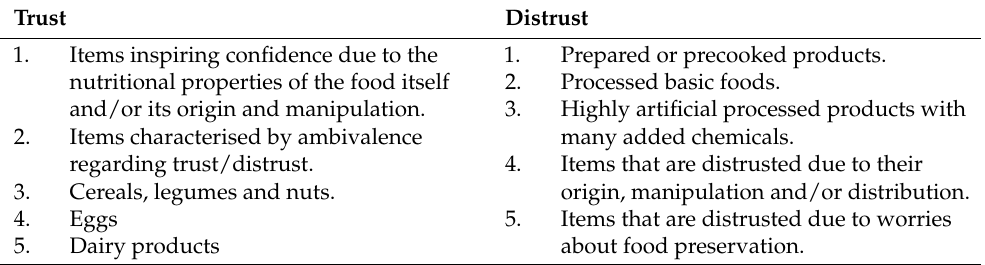
Table 4. Clusters or dimensions in the nMDS related to trust ( n = 5) and distrust ( n = 5) in food